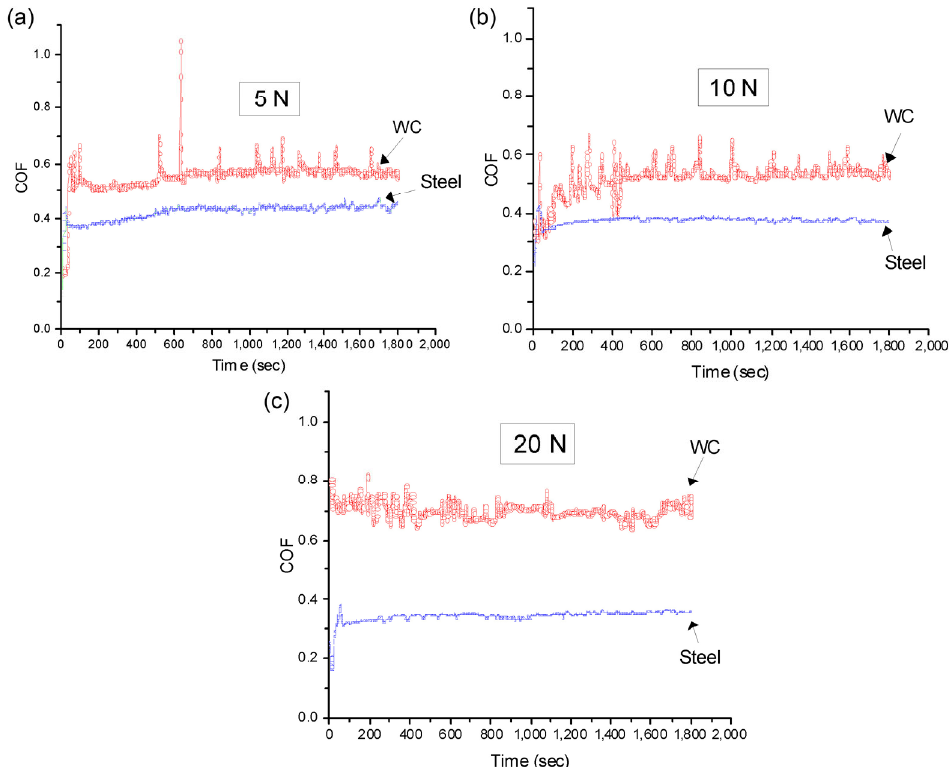
Fig. 2 Evolution of coefficient of friction for monolithic SiC ceramics at (a) 5 N; (b) 10 N and (c) 20 N, against WC-Co and steel